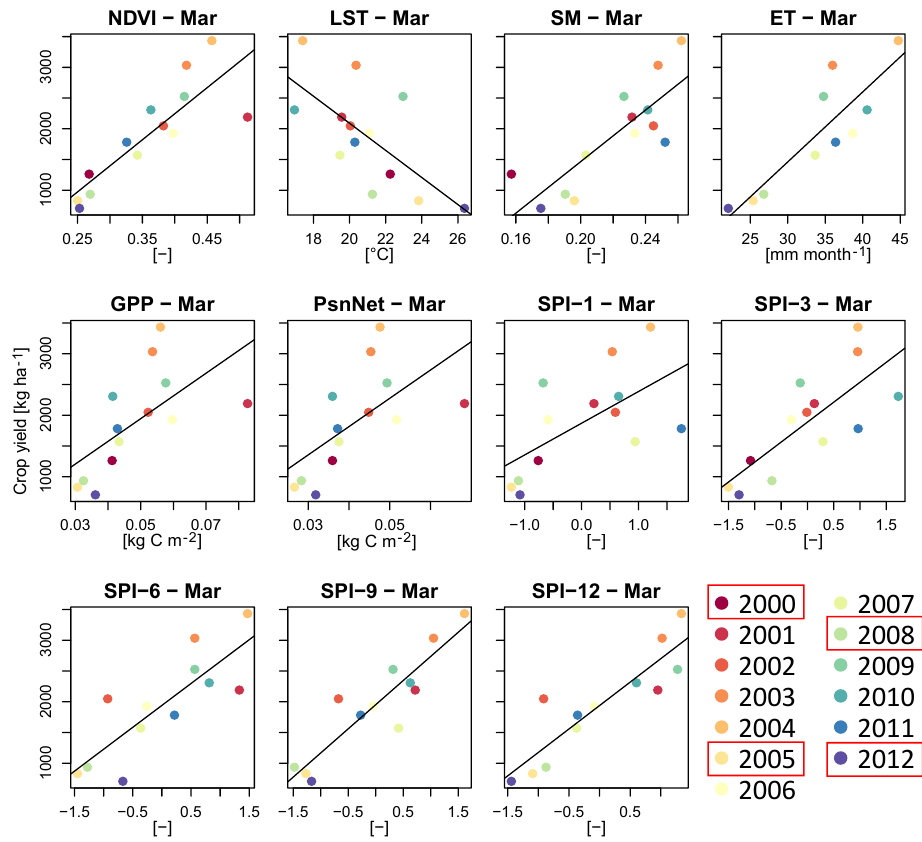
Figure 7. Correlation of the remote sensing drought indicators for the month of March to annual rain-fed two-row barley yield in Monegros- Bajo Cinca districts (MB). For LST, NDVI, SM, ET, GPP and PsnNet, monthly means were